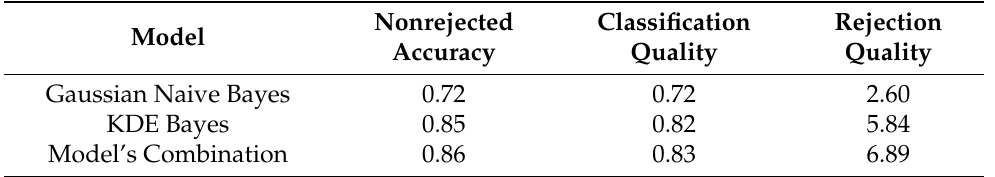
Table 2. Performance measures for individual models (Gaussian naive Bayes and KDE Bayes) and a combination of both models. The results were obtained using a rejection fraction of 10% and a training size of 90,000